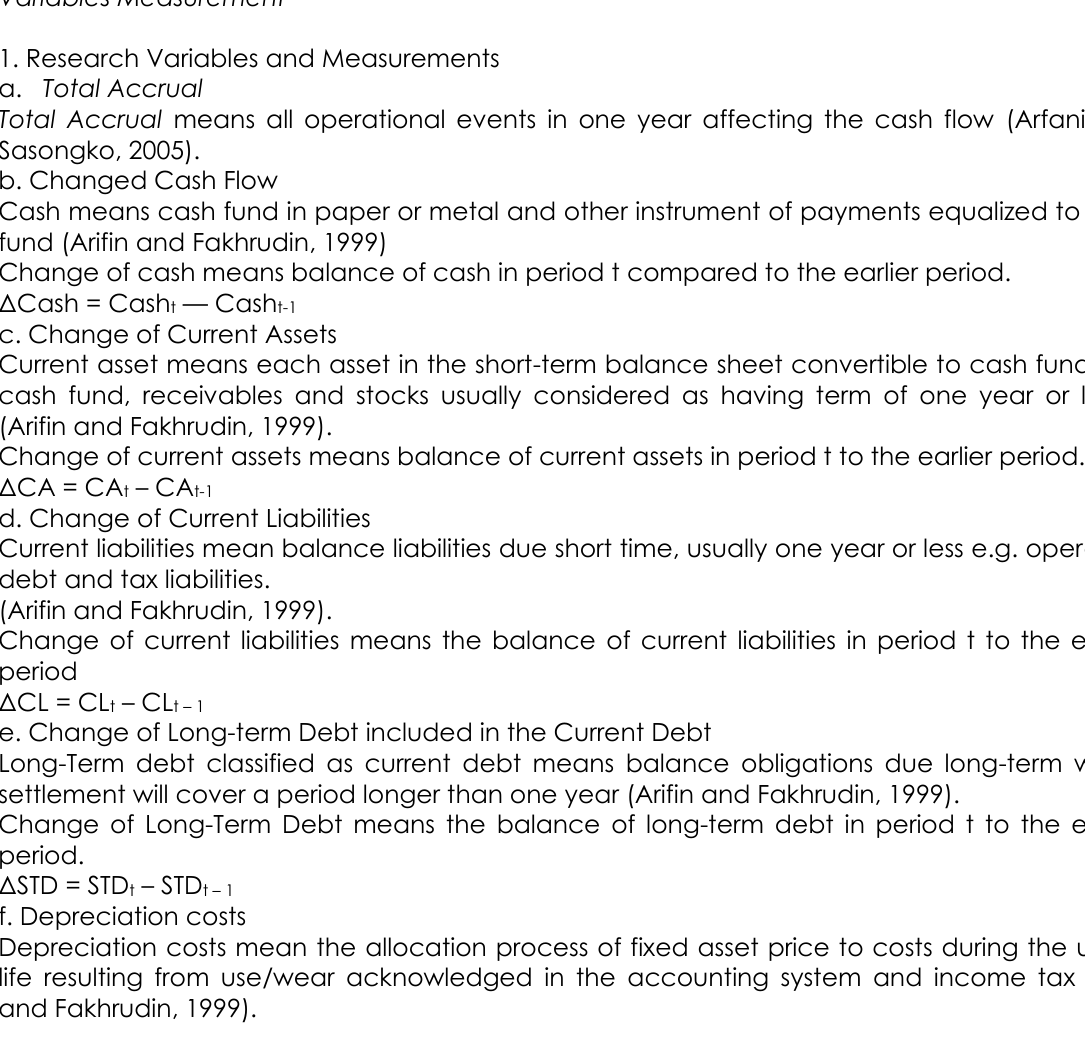
Table 1. Sample Descriptive Statistics